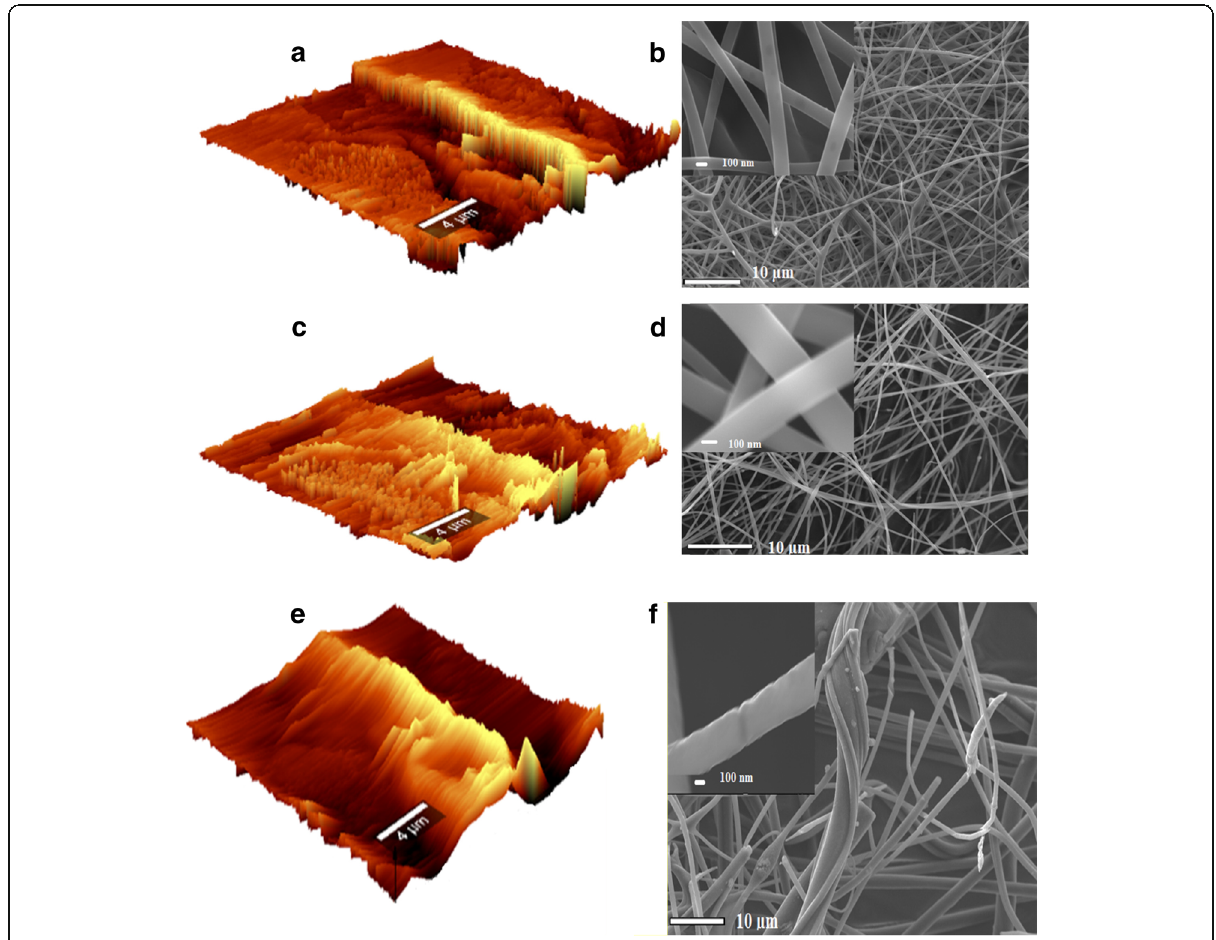
Fig. 3 Atomic force microscope images of a PAN nanofibers, c PAN/ZrP nanofibers, e PAN Nafion/ZrP nanofibers. The insert shows SEM images of b PAN, d PAN/ZrP and f PAN Nafion/ ZrP nanofibers at scale bars of 10 μ m and 100